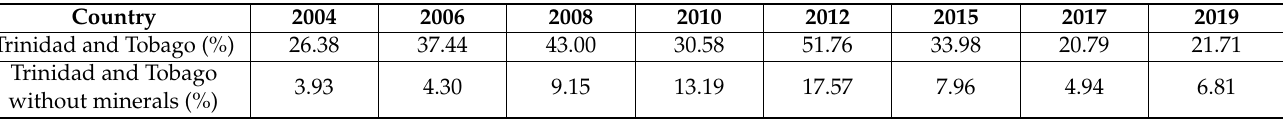
Table A4. Trends in potential for import substitution in T&T